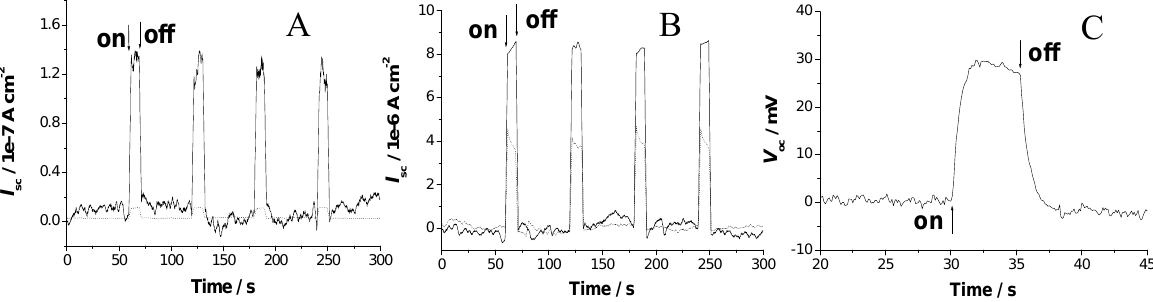
Figure 3. Short-circuit photocurrent ( I ) responses of the RC-free TiO film (a, dotted sc 2 line) and the RC/TiO film (b, solid line) in the pH 8.0 Tris-HCl buffer containing 2 8 mM sodium dithionite illuminated with an 20 W incandescent lamp coupled = 0.1 mW cm -2 ) or not (B, I = 5 mW cm -2 ). (C), The open- with a filter (A, I inc inc circuit photovoltage ( V ) responses of the RC/TiO film (I = 5 mW cm -2 oc 2 inc